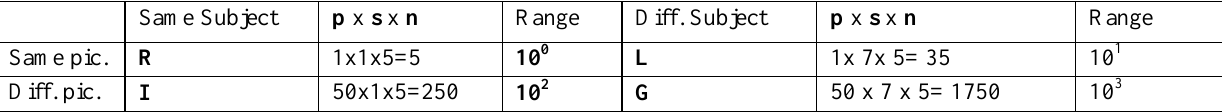
Table 3: Number of strings that contribute to each index in the parsing table (25 picture-pairs = 50 pictures, times 5 presentations, times 7 subjects), which means that different subjects (7) looking at the same picture(1) should show less variant strings than different subjects (7) looking at many different pictures (50). This is due to the low numbers of strings that contribute to that measure; Similarity of strings in decreasing order: R epetitive, I diosyncratic, L ocal, G lobal. Ss parsing tables show that the probability of similarities decreases to about one half of Sp, due to the high number of vector directions compared to the lower and constant number of possible fixation